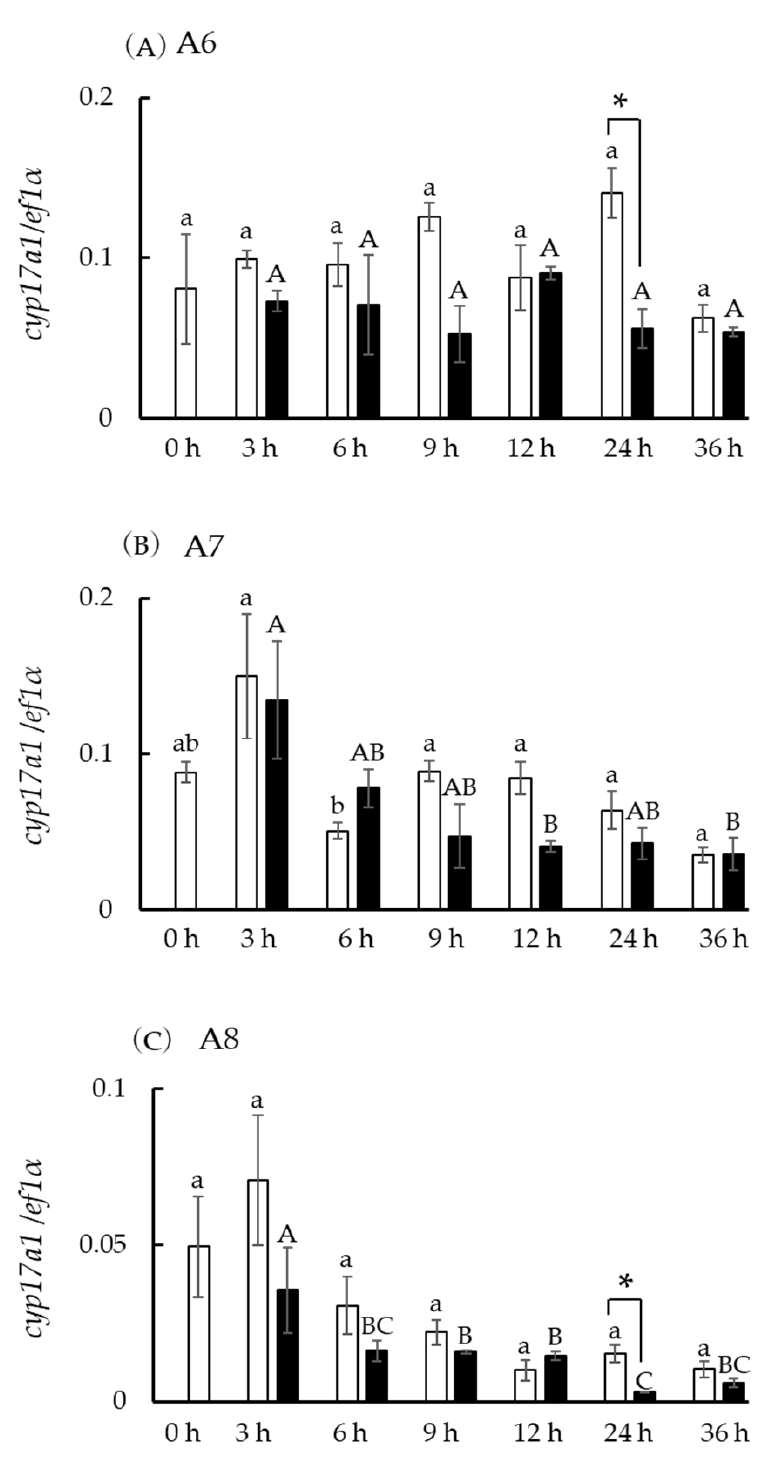
Figure 10. cyp17a1 expression in incubated ovarian follicles from A6, A7, and A8. Levels of mRNA from follicles incubated in media alone (white column) and in 500 µ g/mL SPE (black column). Panels ( A – C ) indicate individuals A6, A7, and A8, respectively. Table A6, A7 and A8 were used at 8 h after injection of LHRHa. Each vertical bar represents the mean ± SE of three replicate incubations. Different letters (control: a, SPE: A) represent a significant difference among groups ( p < 0.05). * p < 0.05.